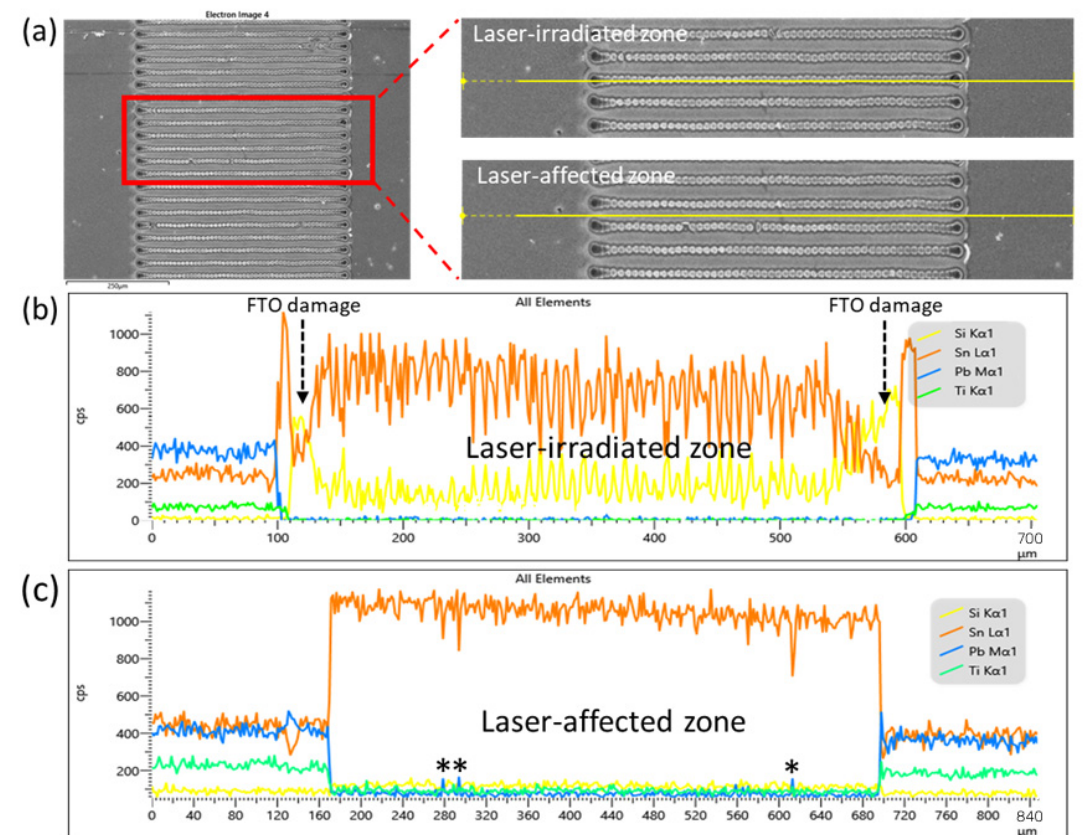
Figure 3. ( a ) SEM images of P2 scribing and EDX line scans on ( b ) LIZ and ( c ) LAZ. PSM architecture for individual cell measurement. Note: * is marked occasional Pb peak signal in LAZ.